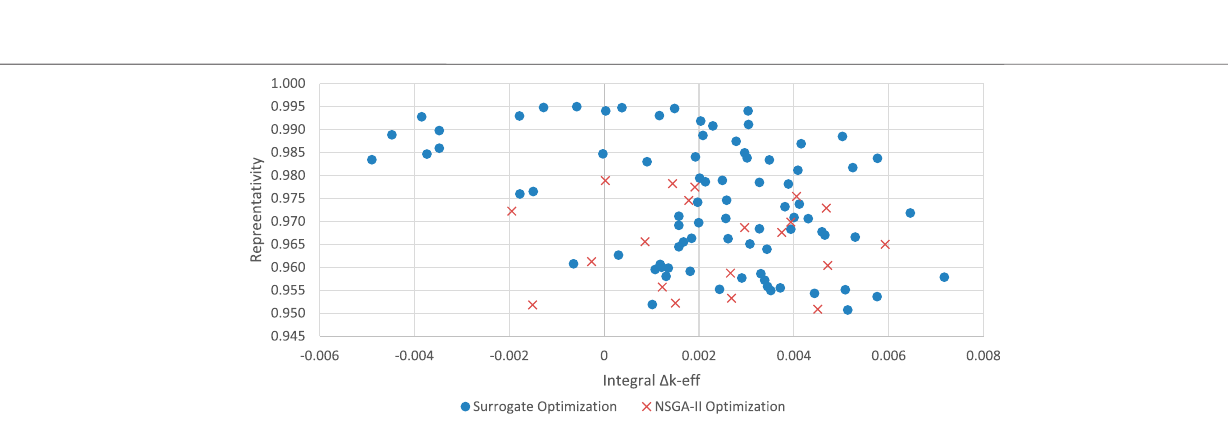
FIGURE 8 | Comparison of Pareto Front Individuals from Both Optimizations, Representativity vs . Integral Experiment Δ